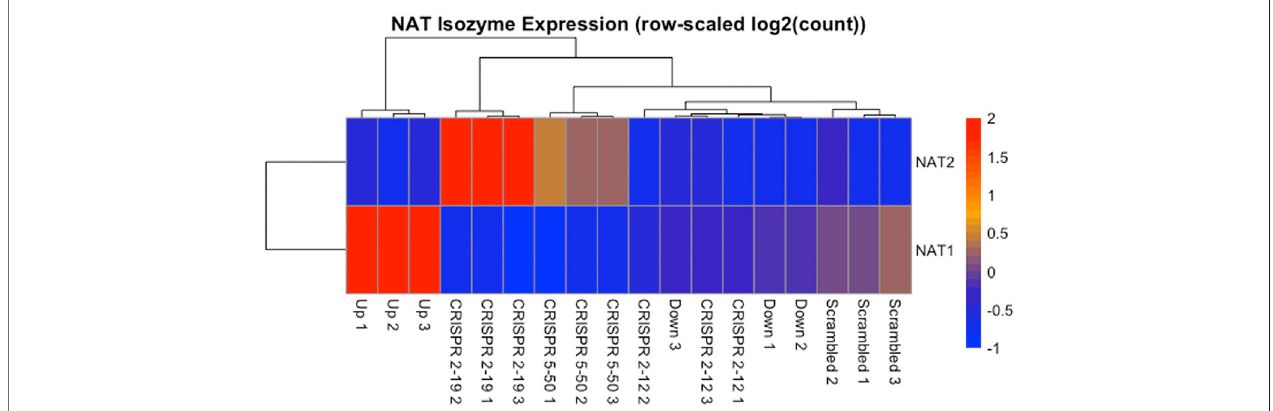
FIGURE 5 | NAT Isozyme Expression is Inversely Related. The expression of NAT1 and its isozyme NAT2 were plotted as a heatmap for comparison. This data showstheinverserelationshipbetweenexpressionofNAT1andNAT2ineachsample.WhenNAT1transcriptexpressionishigh,NAT2transcriptexpressionislow,and conversely, when NAT1 transcript expression is low, NAT2 transcript expression is high. Each row of the heatmap shows the expression for a single gene while each column shows gene expression for an individual sample. Expression values have been transformed to Z-scores with red colors representing high expression and blue colors representing low